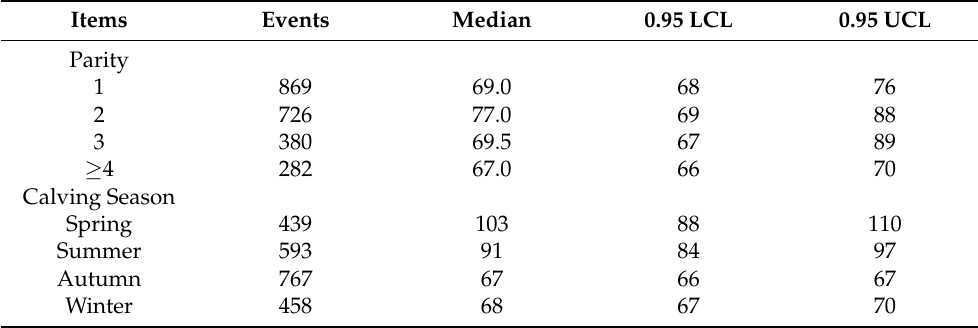
Figure 2. Least-squares means and corresponding standard error of DO at different levels of calving season ( A ) and parity ( C ) inferred by linear mixed model. Survival analysis of DO based on parity ( B ) and calving season ( D ) was carried out by the Kaplan–Meier method. The horizontal dotted line indicates the median survival rate in survival analysis. The vertical dotted lines indicate the median survival time at different levels of parity and calving season in survival analysis. Different letters show significant differences ( p < 0.05). Table 2. Summaries of survival analysis of DO based on parity and calving